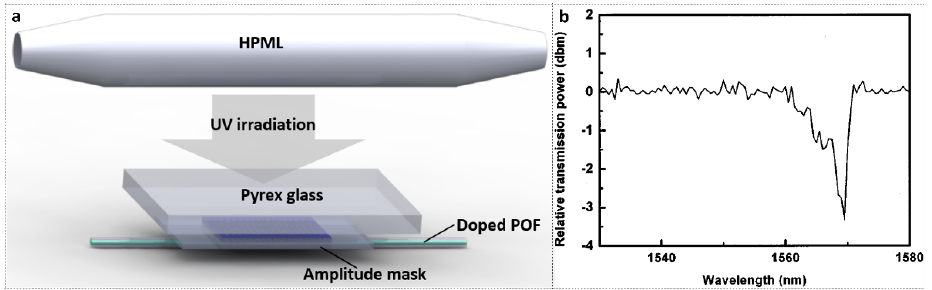
Figure 19. ( a ) Experimental set ‐ up of LPFG inscription in an MVK ‐ doped POF with an HPML; ( b )